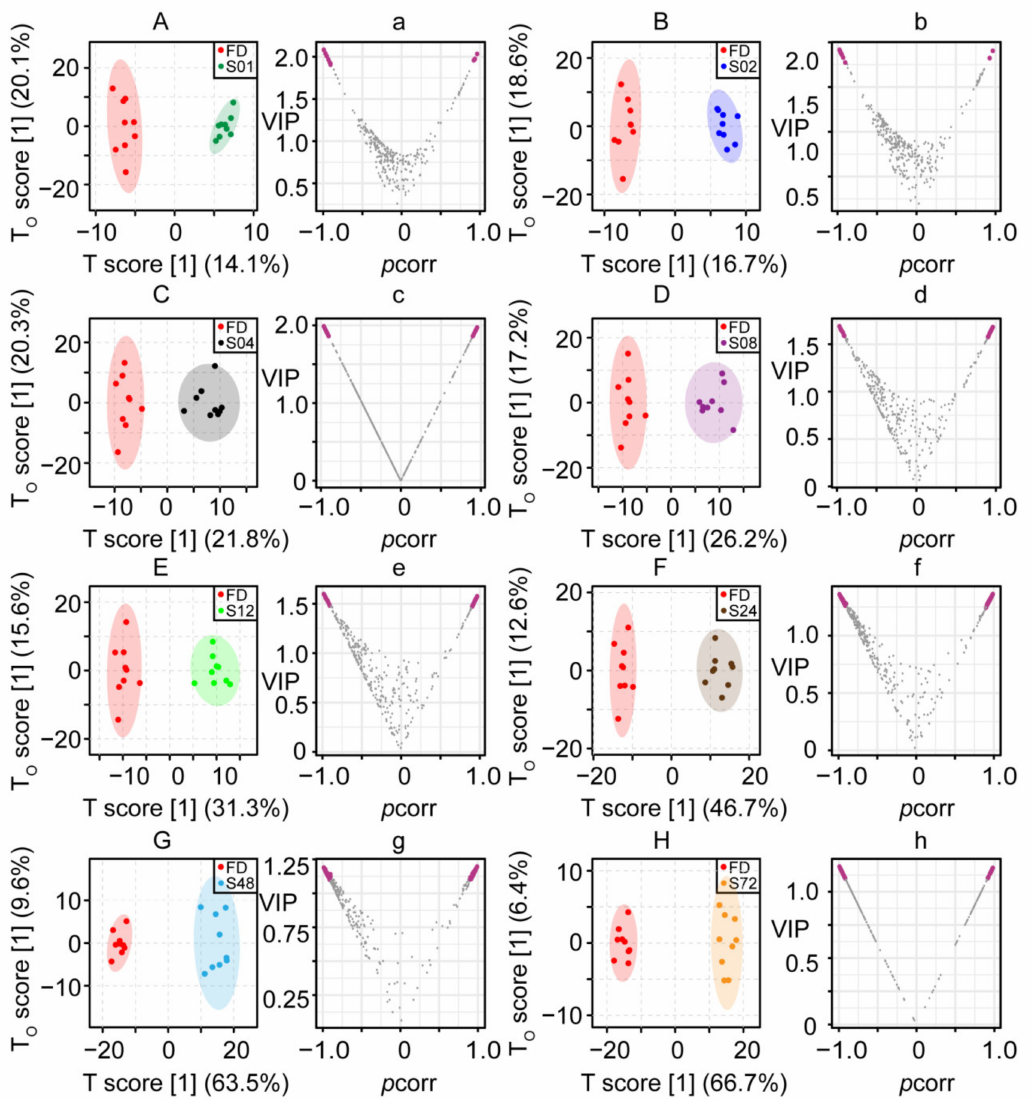
Figure 2. The OPLS-DA score plots of 2D 1 H- 13 C HSQC spectra of SR steamed for different durations. Comparison between vacuum freeze-dried (FD, red) samples and samples steamed for ( A ) 1 (S01, green), ( B ) 2 (S02, blue), ( C ) 4 (S04, black), ( D ) 8 (S08, purple), ( E ) 12 (S12, light green), ( F ) 24 (S24, brown), ( G ) 48 (S48, light blue), and ( H ) 72 h (S72, yellow). The volcano plots of VIP and p (corr) of variables from OPLS-DA between vacuum freeze-dried (FD) samples and samples ( a ) S01, ( b ) S02, ( c ) S04, ( d ) S08, ( e ) S12, ( f ) S24, ( g ) S48, ( h ) S72. Differential variables with VIP > 1.1 and | p (corr)| > 0.9 are highlighted in